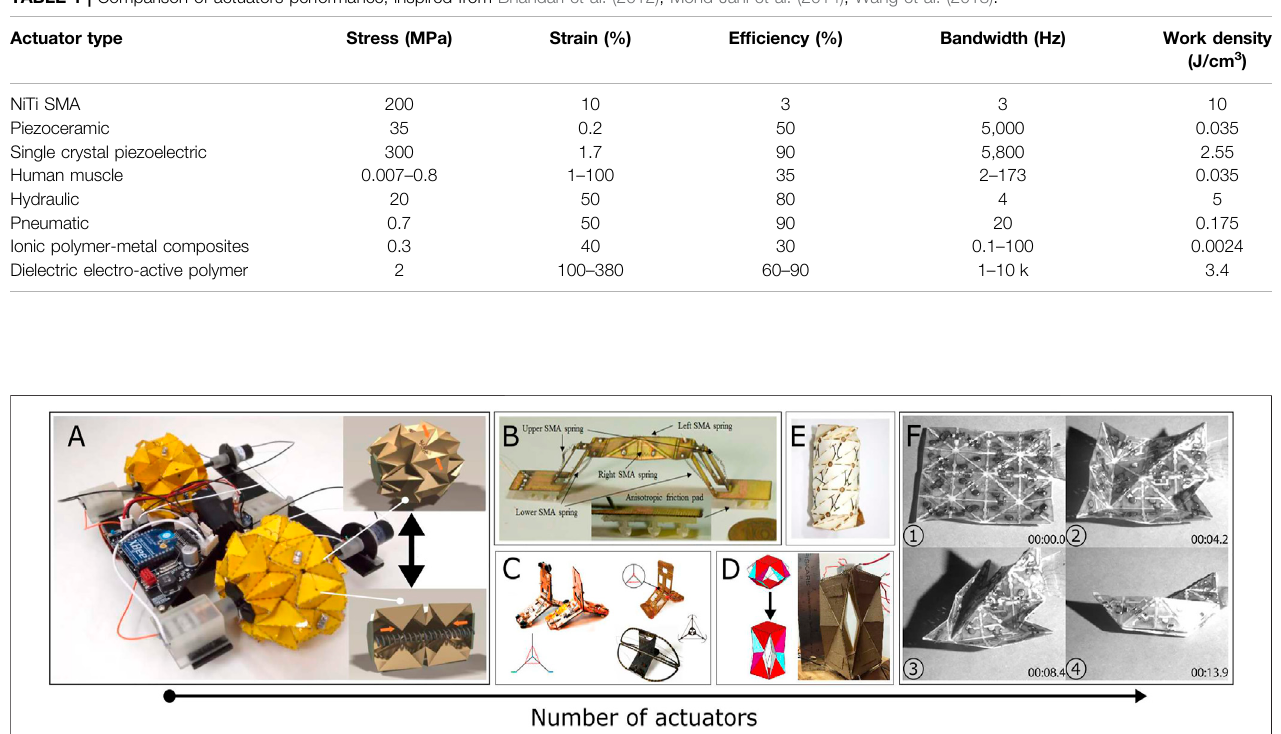
Frontiers in Robotics and AI |